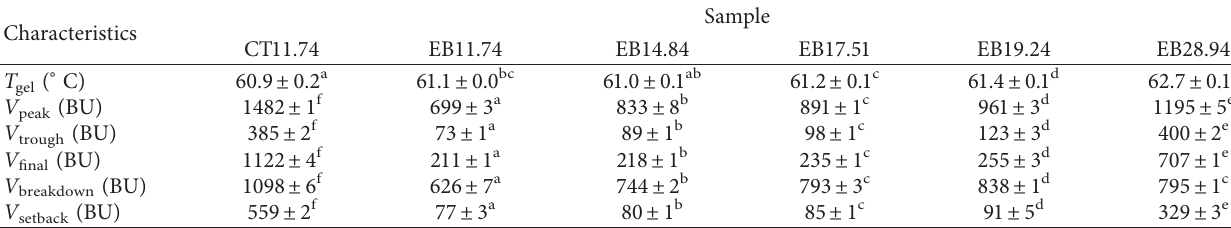
Table 2: Pasting properties of the starch samples.